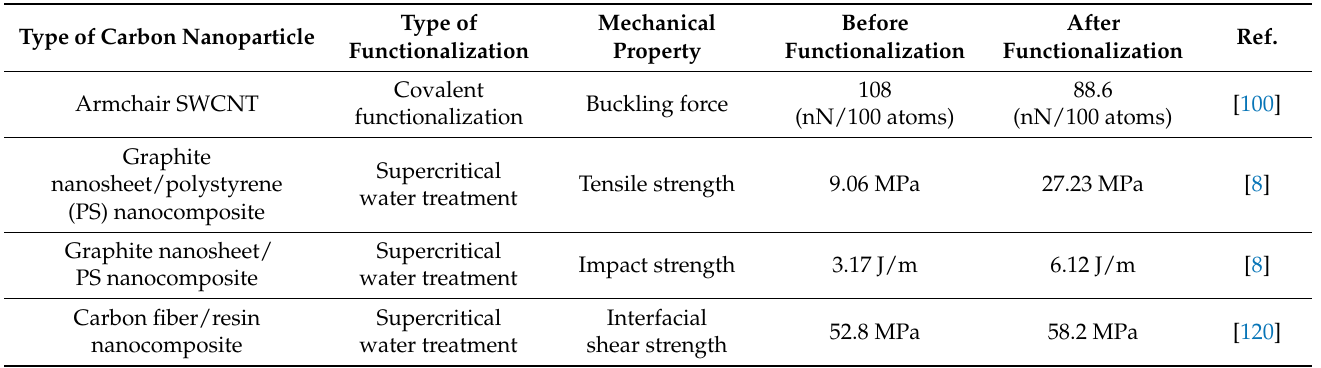
Table 6. Various mechanical properties of carbon nanoparticles before and after